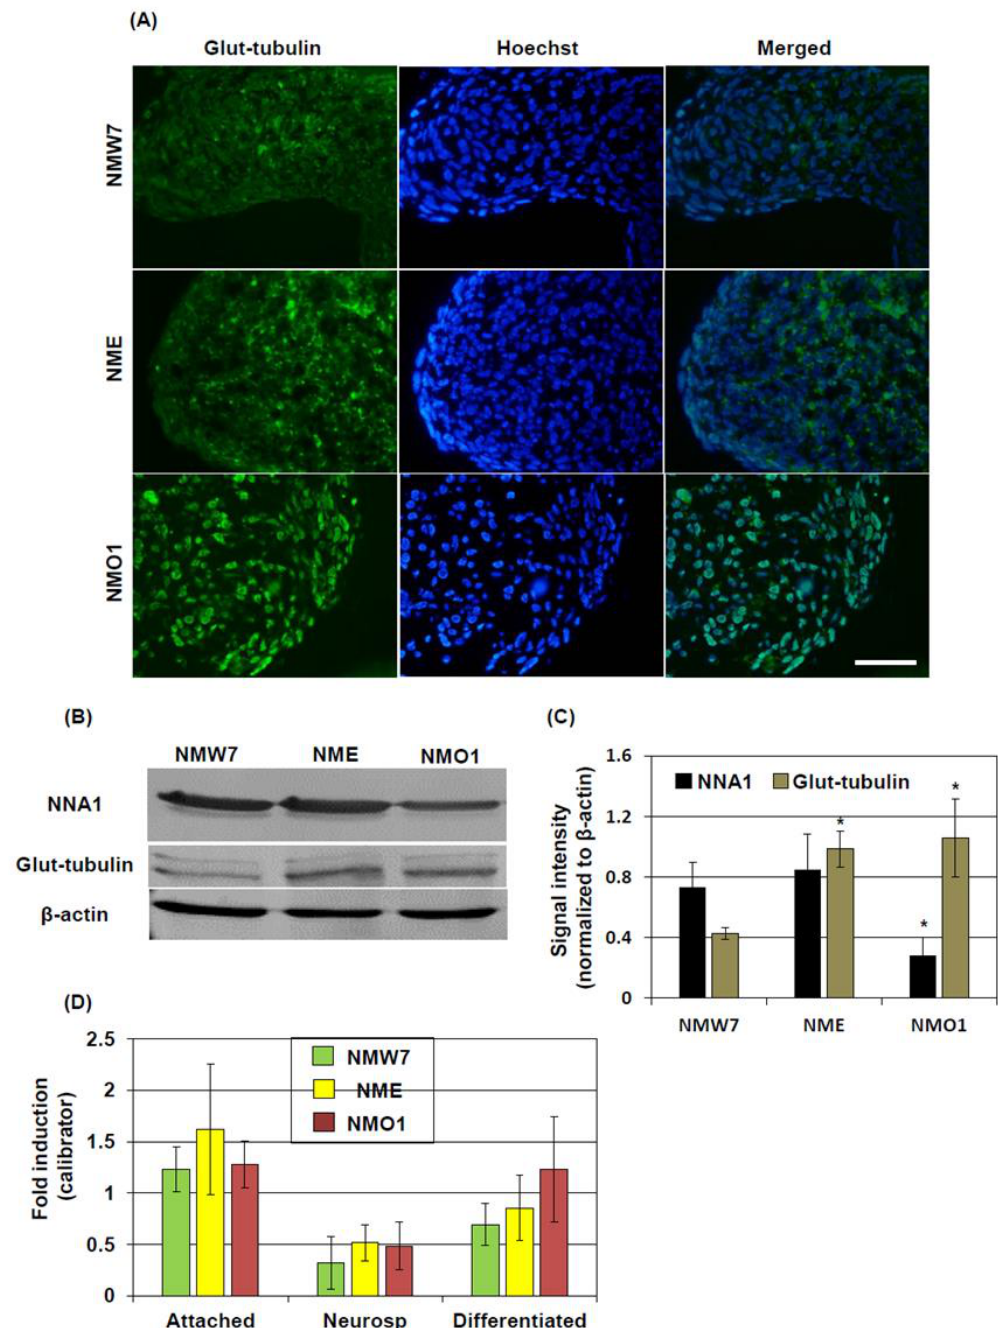
Figure 4. Protein modification and mRNA expression of β -tubulin in NSC culture: Neurospheres were prepared from NMW7, NME, and NMO1 NSCs. ( A ) Glutamylation of tubulin in neurospheres was evaluated by immunofluorescence staining. ( B , C ) Glutamylated tubulin and NNA1 levels in neurosphere cultures were further evaluated by Western blotting. ( B ) Representative Western blotting results of glutamylated tubulin and NNA1 are shown here. β -actin was used as a loading control. ( C ) NNA1 and glutamylated tubulin were quantified by densitometry. Averages of the dentisometric data are shown ( n = 3). ( D ) To evaluate the β -tubulin mRNA levels, total RNA was isolated from NSC attached culture (Attached), neurospheres (Neurosp), and after neuronal differentiation (Differentiated), and real-time PCR was performed as described in the Materials and Methods section. Average ± SD of 3 individual real-time PCR experiments are shown. Statistical significance is denoted as follows: * p < 0.05 vs. NMW7. Scale bar = 50 µM.